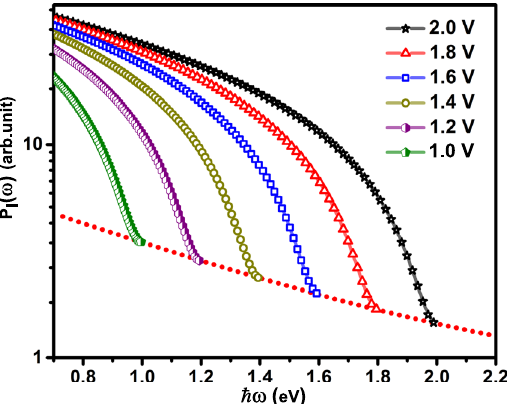
Figure 4. Semi-log plot of P I ( ω ) vs . energy (for k B T = 25 meV) for various applied bias between 1–2 V (Red dotted line shows an exponential fit to residual P I ( ω ) at ħ ω co = eV b ).